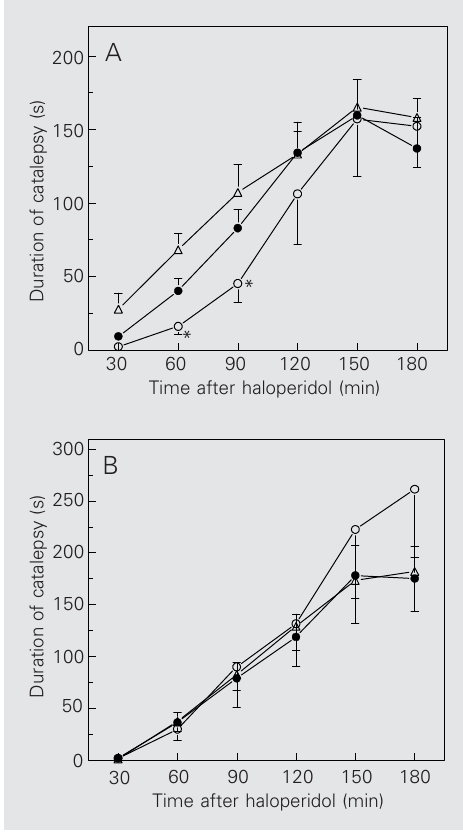
Figure 2. Effects of linsidomine (SIN-1) on neuroleptic-induced catalepsy in male (A) and female (B) mice. SIN-1, or appropriate vehicle as control, was injected ip 30 min before haloperidol (1 mg/kg, ip ). Data are reported as means ± SEM, N = 10 mice per group. Filled circles, vehicle; tri- angles, 10 mg/kg SIN-1; open circles, 50 mg/kg SIN-1. *P < 0.05 compared to vehicle (Dunnett